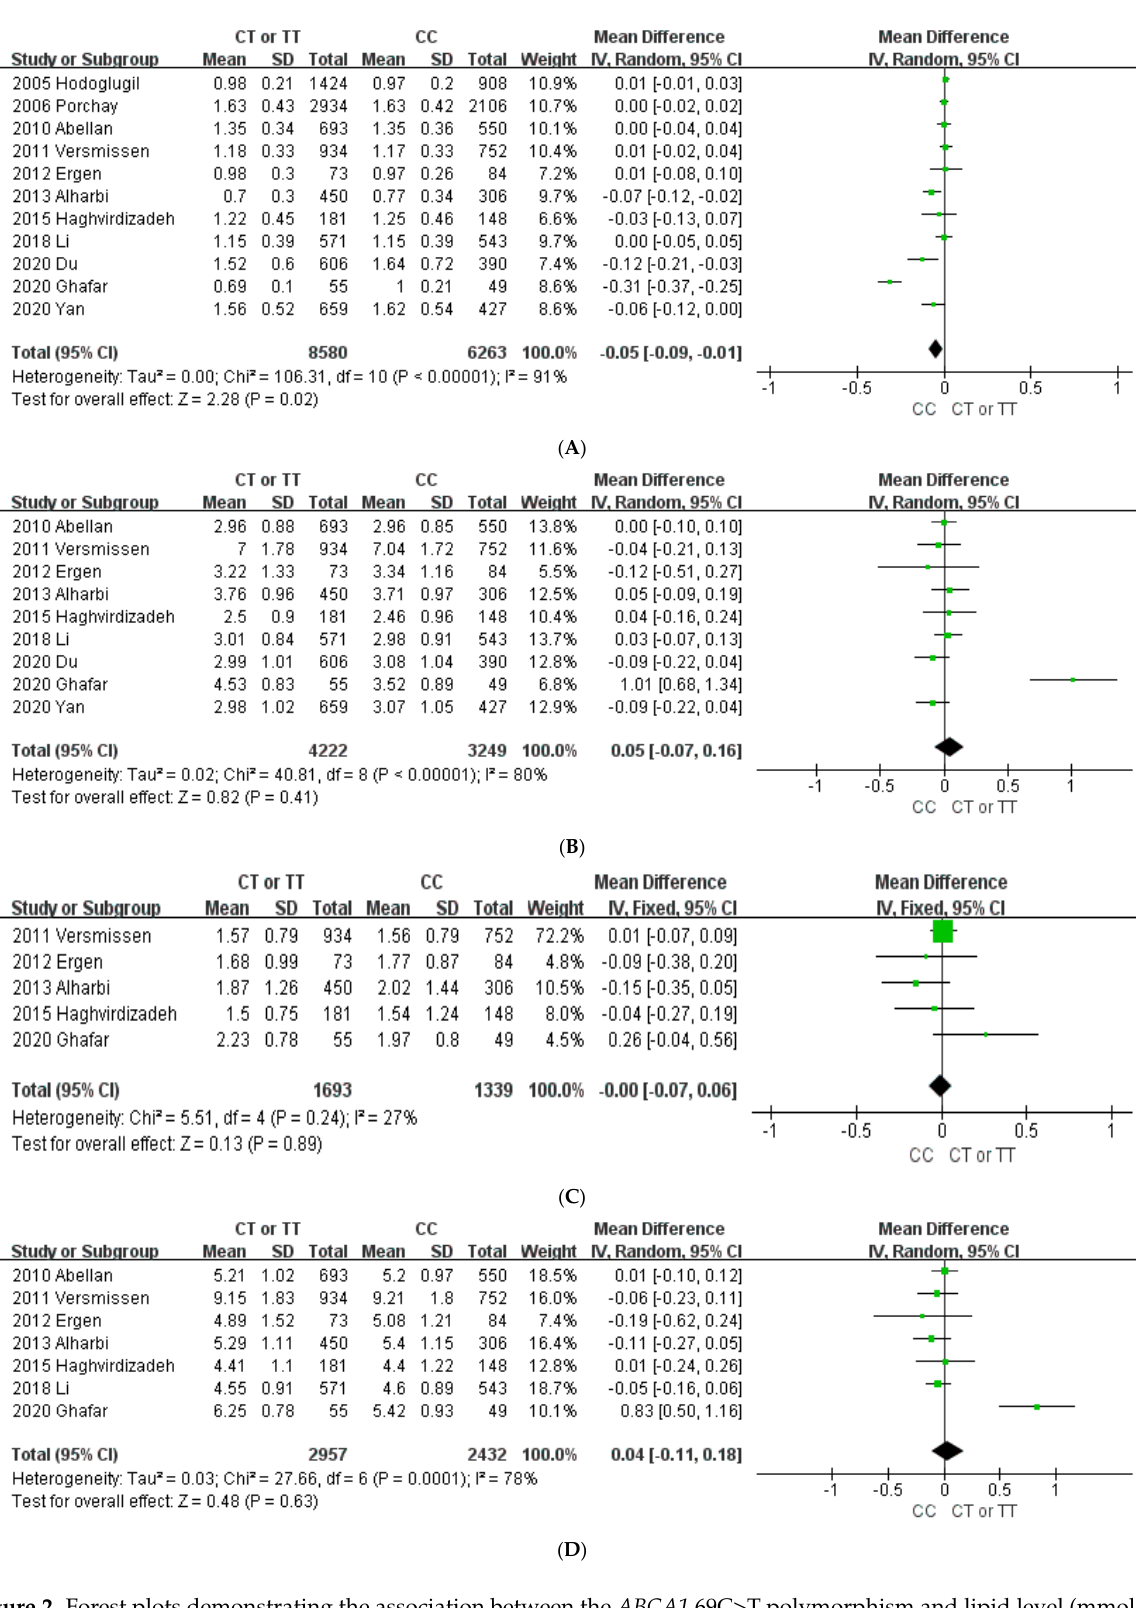
Figure 2. Forest plots demonstrating the association between the ABCA1 69C>T polymorphism and lipid level